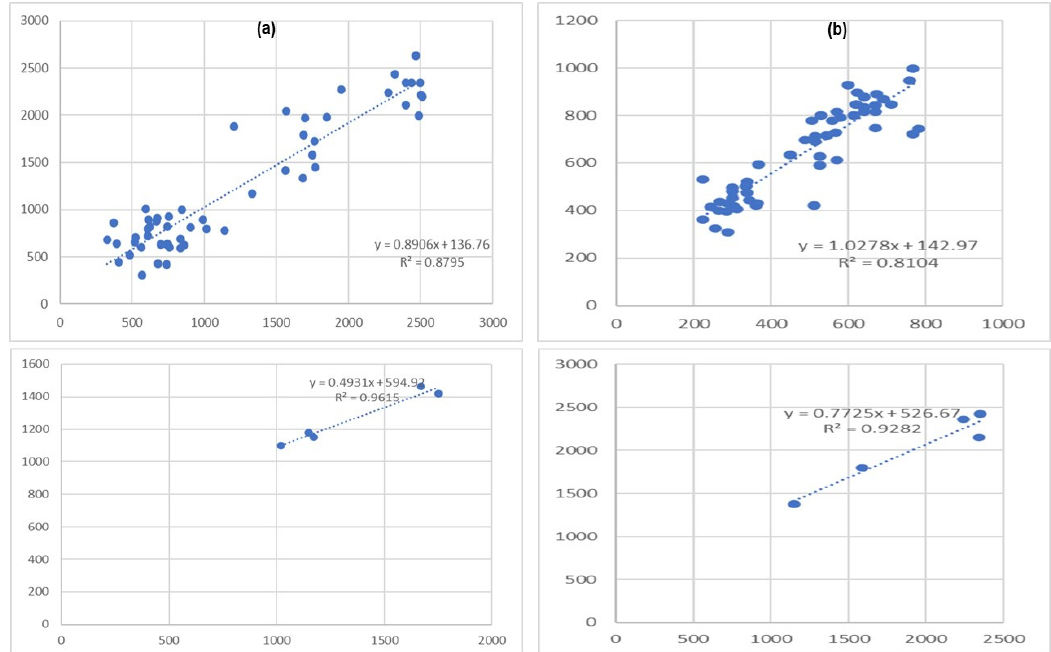
Figure 8. Calibration and validation of the APSIM-cotton model to compare the simulated and observational yield (kg/ha − 1 ) data with different sowing dates ( a ) simulated and recorded yield in Xinjiang (1980–2018); ( b ) simulated and recorded yield in Punjab (1961–2015), where for long-term yield p = 0.31 and observational yield p = 0.93.